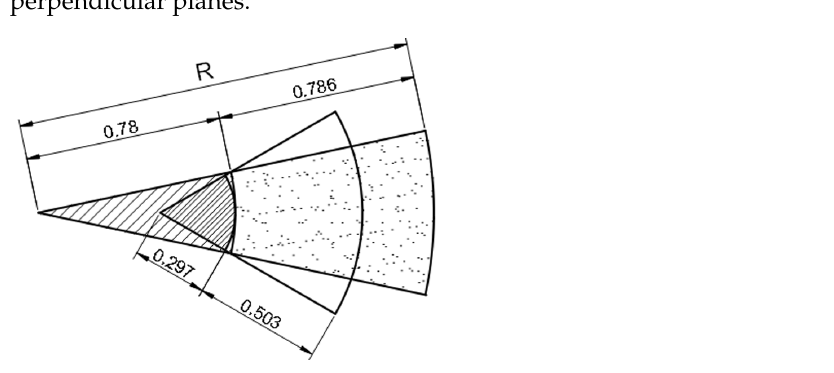
Figure 1. Tributary volumes of same magnitude and different shape (microns) for same τ w